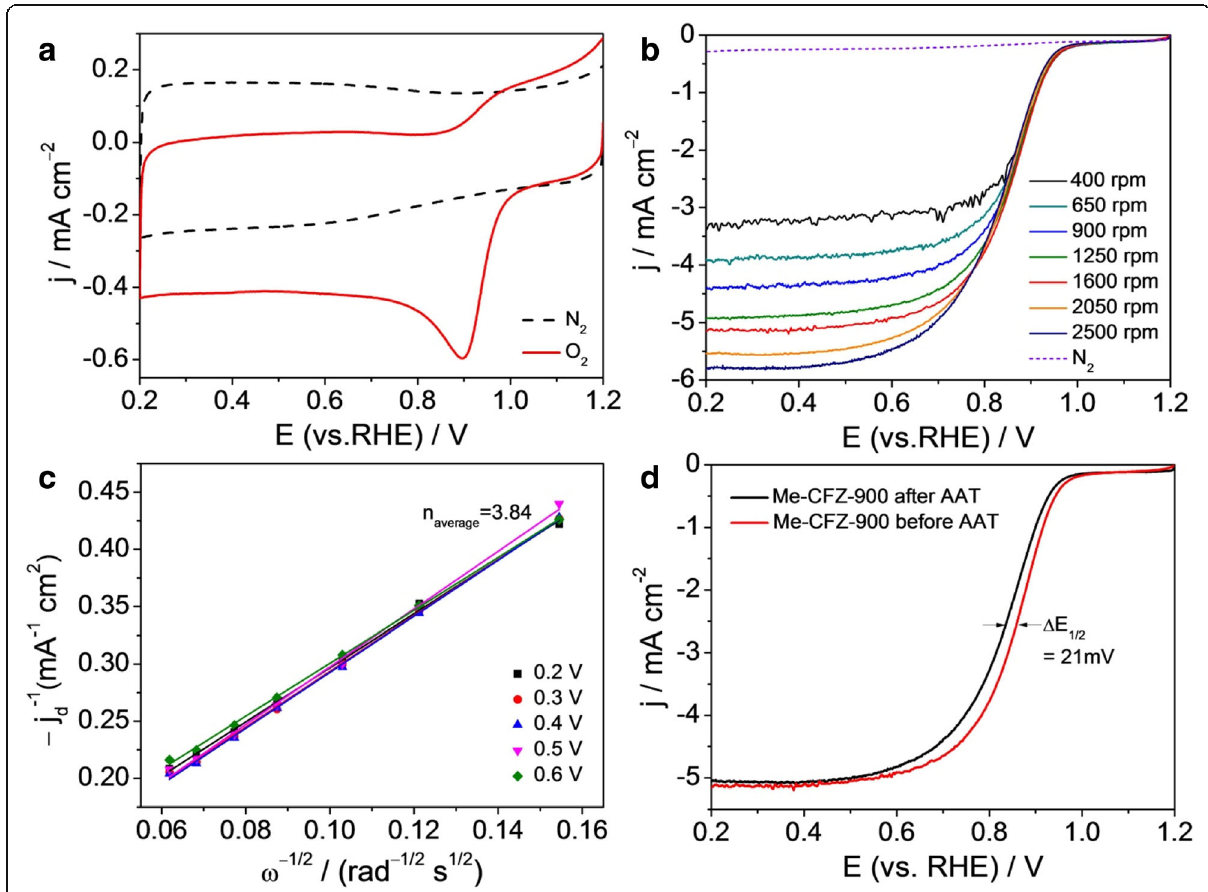
Fig. 7 a CV curves of Me-CFZ-900 in 0.1 mol l − 1 KOH solution saturated by N 2 versus O 2 . b LSV curves of Me-CFZ-900 in O 2 -saturated 0.1 mol l − 1 KOH solution at different rotation speeds (400 – 3600 rpm). c Koutecky-Levich plots of j d − 1 vs. ω − 1/2 obtained from b at given potentials. d LSV curves of Me-CFZ-900 in O 2 -saturated 0.1 mol l − 1 KOH electrolytes before and after AAT